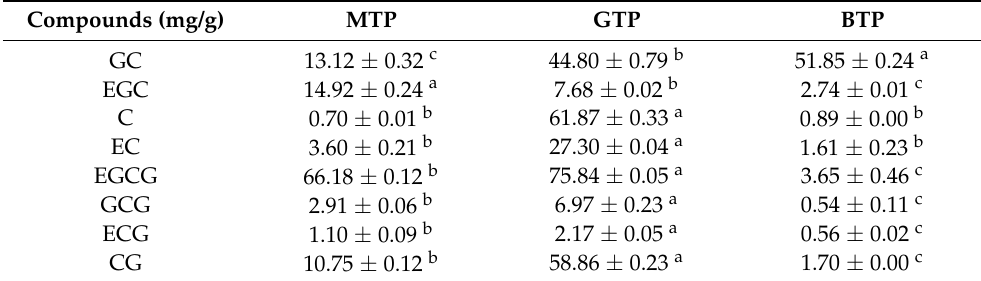
Table 2. Content of catechin monomers (mg/g) from MTP, BTP, and GTP.